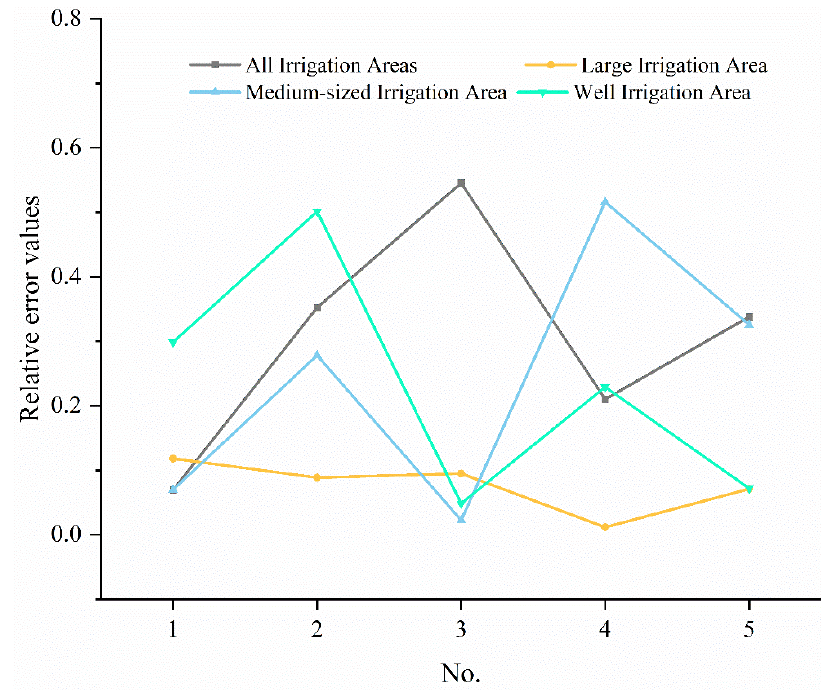
Figure 7. Residuals of various types of irrigation areas ∆ (0) (𝑘) .